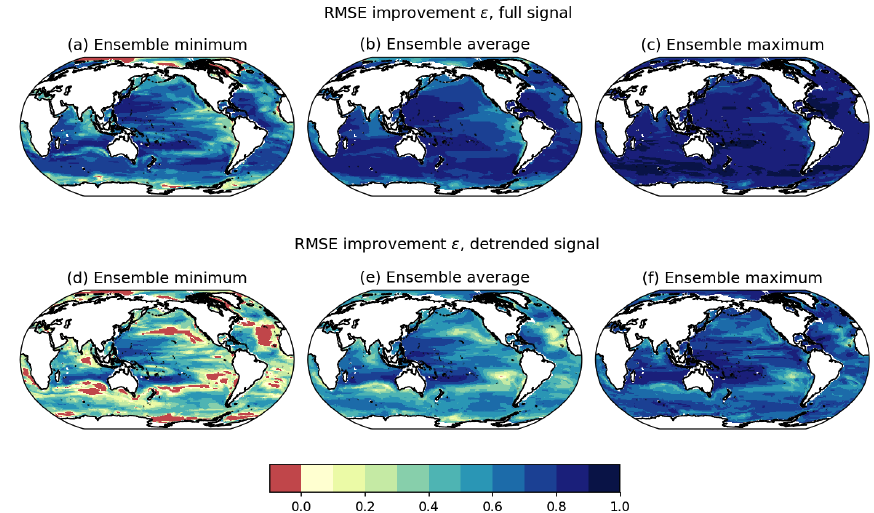
Figure 5. Ensemble statistics for the relative RMSE reductions ε using co-located temperature and salinity over the upper 100m: (a) ensemble minimum, (b) ensemble average, and (c) ensemble maximum. Ensemble statistics for the relative RMSE reductions but considering only the detrended carbon signal: (d) ensemble minimum, (e) ensemble average, and (f) ensemble maximum. Red areas indicate regions where the sensitivity tests show a RMSE increase relative to the assumption of